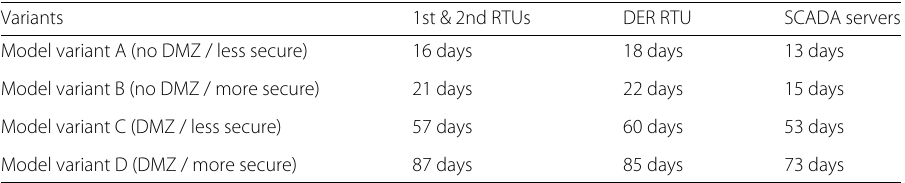
Table 3 Analysis results with an attacker positioned at the Software/Hardware Vendor Variants 1st & 2nd RTUs DER RTU SCADA servers Model variant A (no DMZ / less secure) 16 days 18 days 13 days Model variant B (no DMZ / more secure) 21 days 22 days 15 days Model variant C (DMZ / less secure) 57 days 60 days 53 days Model variant D (DMZ / more secure) 87 days 85 days 73